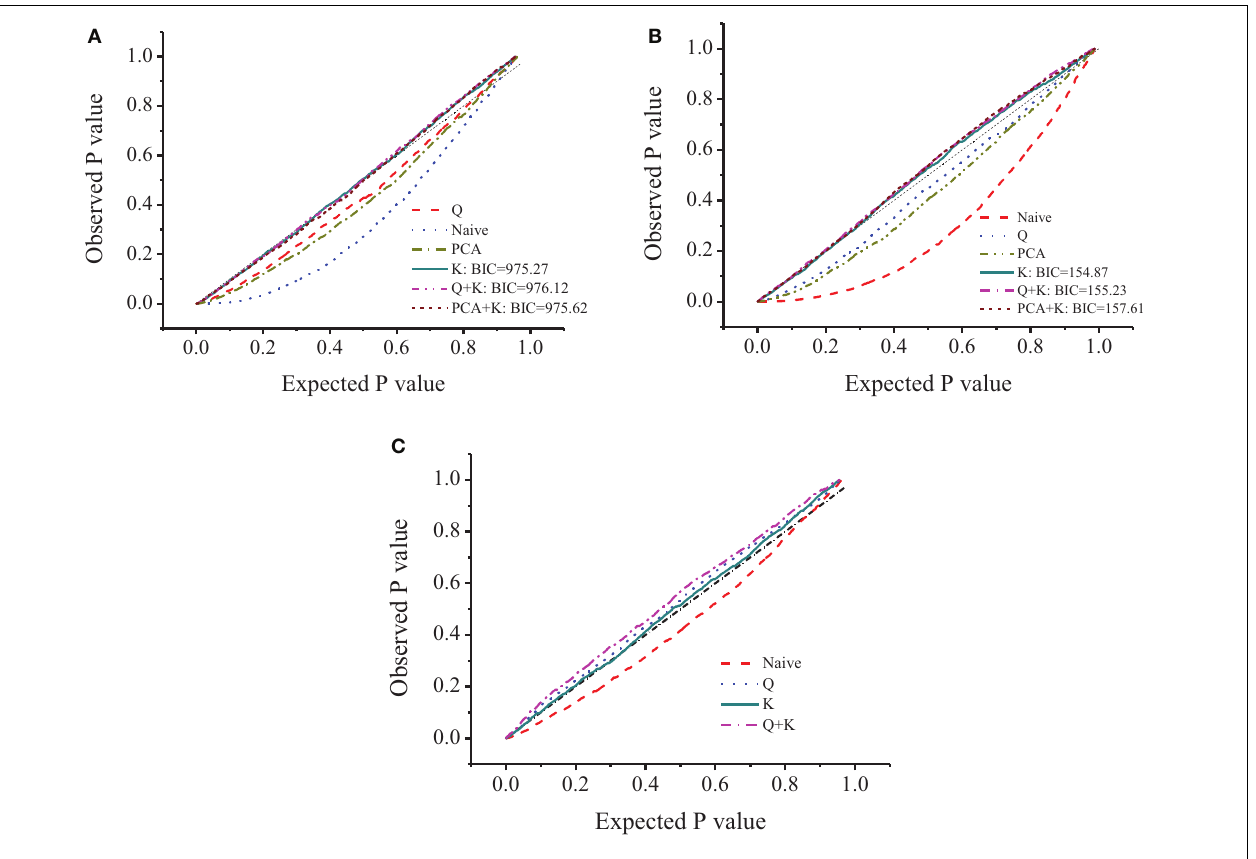
FIGURE 2 | P-P plot of different model for amylose (A), β -glucan (B), and amylopectin (C).